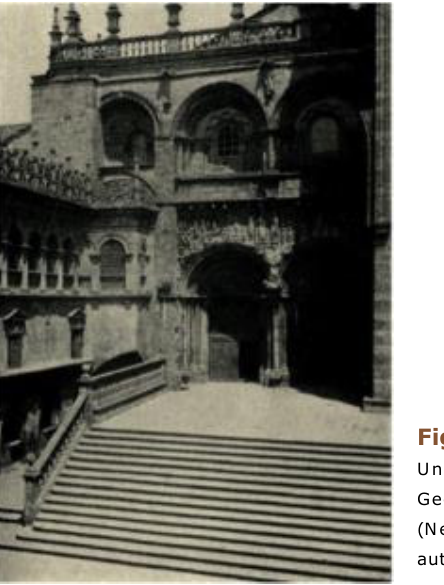
Unidentified photographer, Puerta de las Platerías , from Georgiana Goddard King, The Way of Saint James , vol.